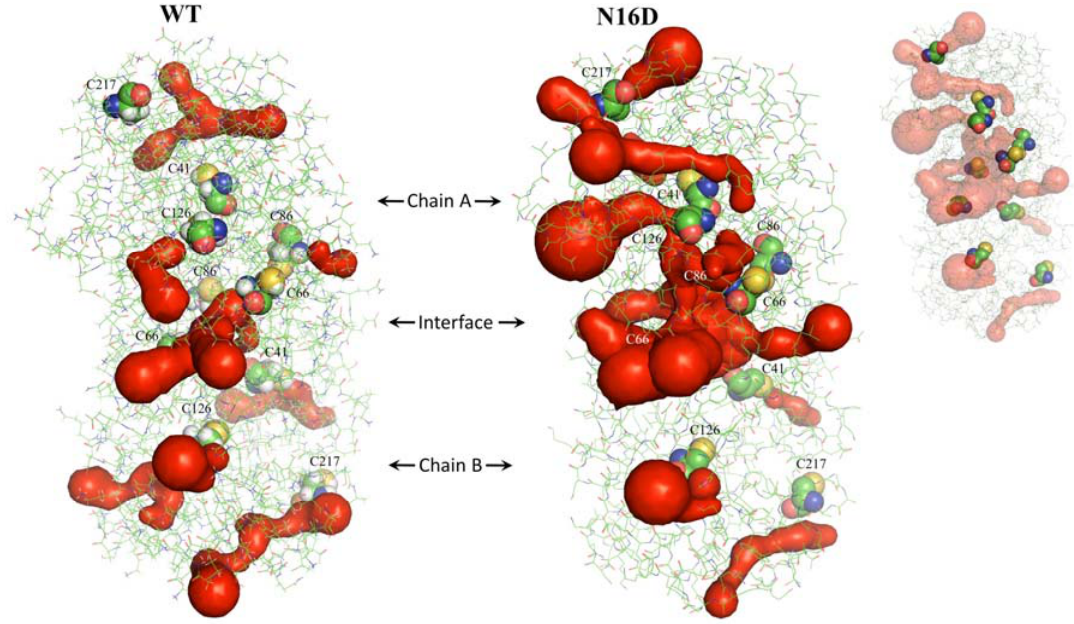
Figure 2. Identification of tunnels in WT and N16D HsTIM. Dimers of both crystallographic structures are shown as green lines, and the surface of tunnels is shown in red. Cys residues are represented with spheres, and the inset shows those hidden in the tunnels. These structures were analyzed with MOLEonline [30] and prepared with PyMOL [28].